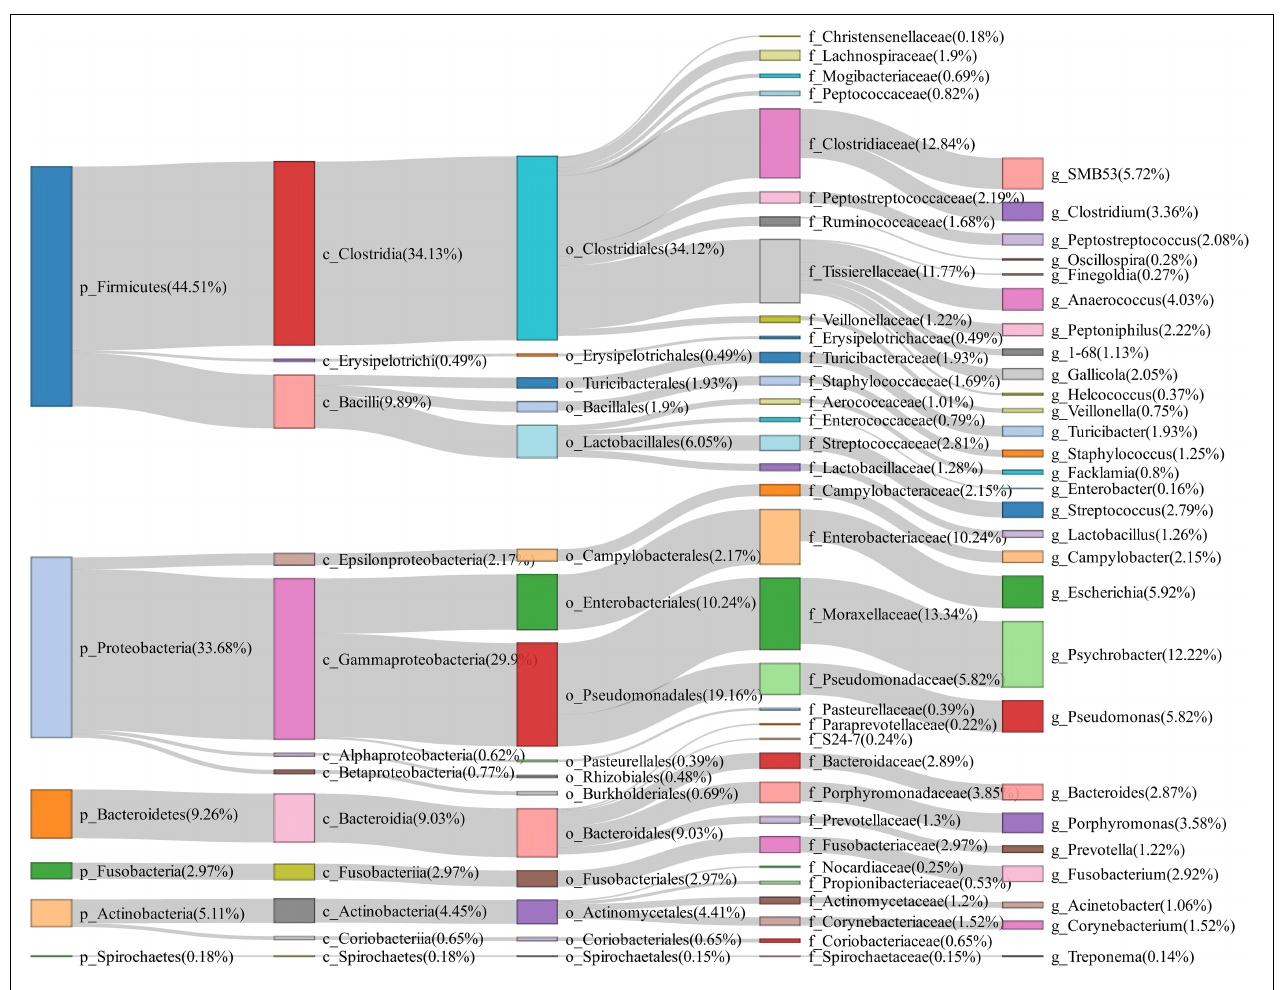
FIGURE 3 | Sankey diagram showing the bacterial composition of vagina swab samples from experimental sows. The colored columns from left to right represent the proportions of bacterial taxa from phylum to genus